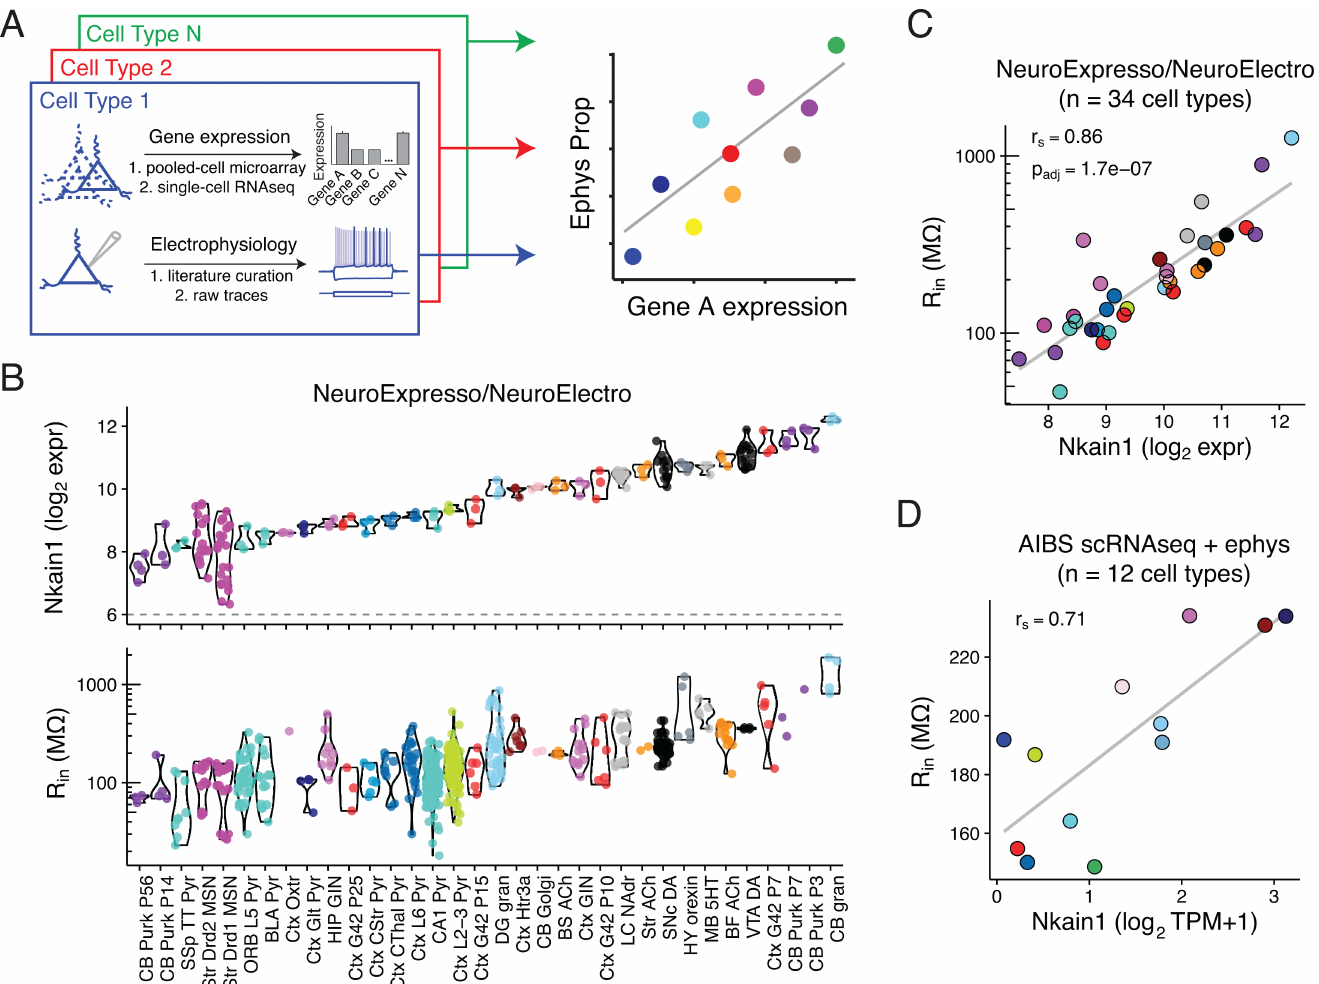
Fig 1. Correlating cell type-specific gene expression with electrophysiological diversity. A) Illustration of transcriptomic and ephys data compilation by cell type (left) and correlationanalysisof single gene expressionby ephys parameter diversity (right). B) Top row: Gene expressionlevels of Nkain1 across 34 neurontypes sampledfrom the combinedNeuroExpresso/NeuroElectro dataset. Each dot reflects a uniquetranscriptomic sample collectedfrom purifiedcells and y-axis is in units of log2 expression(i.e., each increment reflects a 2-fold changein expressionlevel). Dashedline at 6 indicatesapproximate level of background expression. Bottom row: Input resistancevalues for the same cell types in top row. Individual dots reflect populationmean electrophysiologicalvalues manually curated from individualarticles representedin the NeuroElectro database, followingexperimental conditionnormalization.C) Same data as in B, but data has been summarized by the mean (expression, x-axis) or median(ephys, y-axis) value within each cell type. r s indicatesSpearmanrank correlationand p adj indicatesBenjaminiHochberg false discovery rate. Note that cell types with high R in , such as cerebellar granulecells and midbraindopaminergic cells, express high levels of Nkain1 whereascell types with low R in , includingneocortical and hippocampal pyramidal cells, express low levels of Nkain1 .D) Corresponding summary data from the Allen Institute for Brain Science(AIBS) Cell Types dataset. Dots reflect averagedvalues from 12 individual mouse cre-linesand are detailedin Table 2 . Expression values are basedon single-cellRNAseq (scRNAseq), quantifiedas Transcripts Per Million (TPM). Ephys values are based on single-cell characterization in vitro .